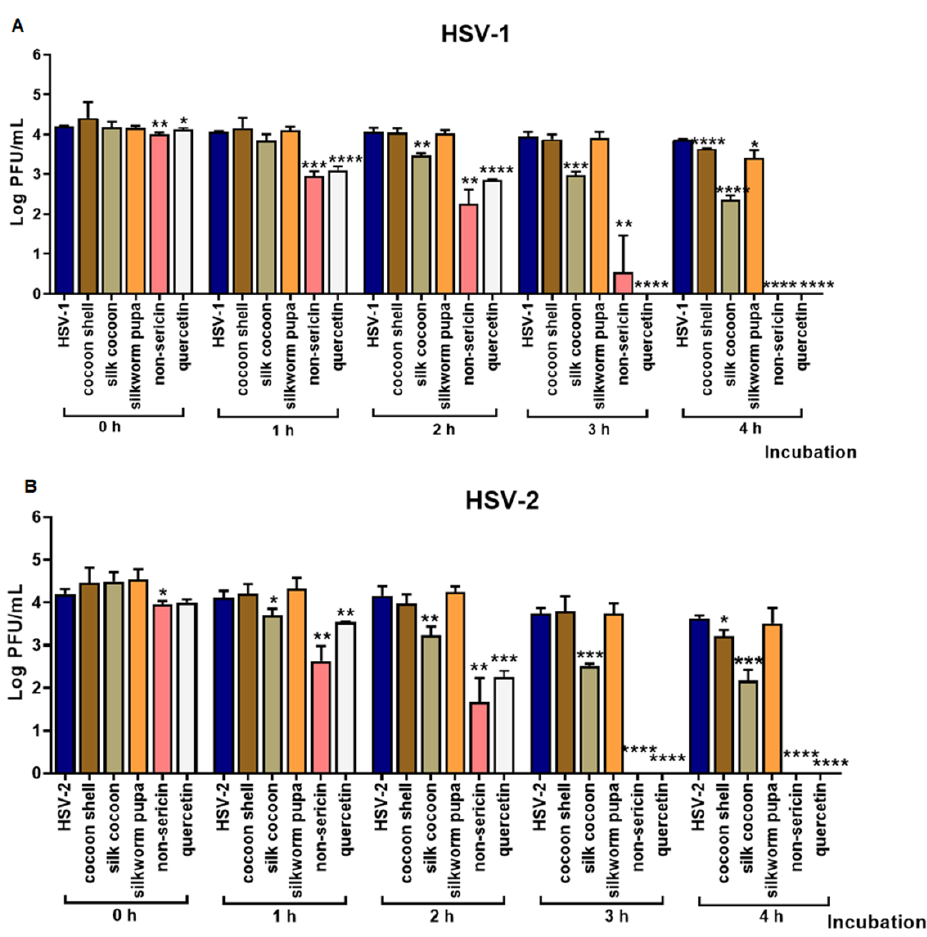
Figure 2. Direct effect of extracts on inactivation of HSV-1 and HSV-2 particles. The viral particles were incubated with the indicated concentrations of each extract at room temperature for 0, 1, 2, 3 and 4 h. Extracts of cocoon shell, silk cocoon, silkworm pupa, non-sericin and quercetin were used at concentrations of 2.5, 1.25, 1.25, 0.625 mg/mL and 80 µg/mL respectively. The infection capacity of HSV-1 ( A ) and HSV-2 ( B ) was evaluated by virus titration assay. The reduction of virus titer after treatment was represented as a log PFU/mL (* indicates p < 0.05; ** indicates p < 0.01; *** indicates p < 0.001, and **** indicates p < 0.0001).